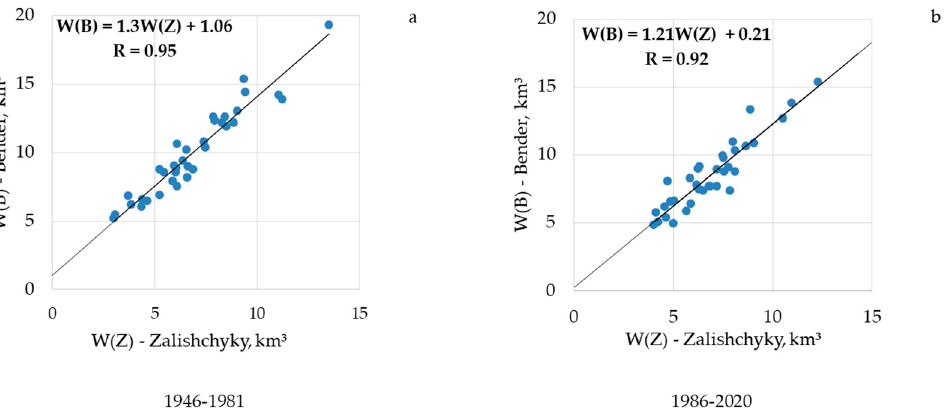
Figure 9. The annual runoff volume W(B) at Bender and W(Z)-Zalishchyky HGS statistical dependence for the period of ( a ) 1946–1981 and ( b ) 1986–2020.